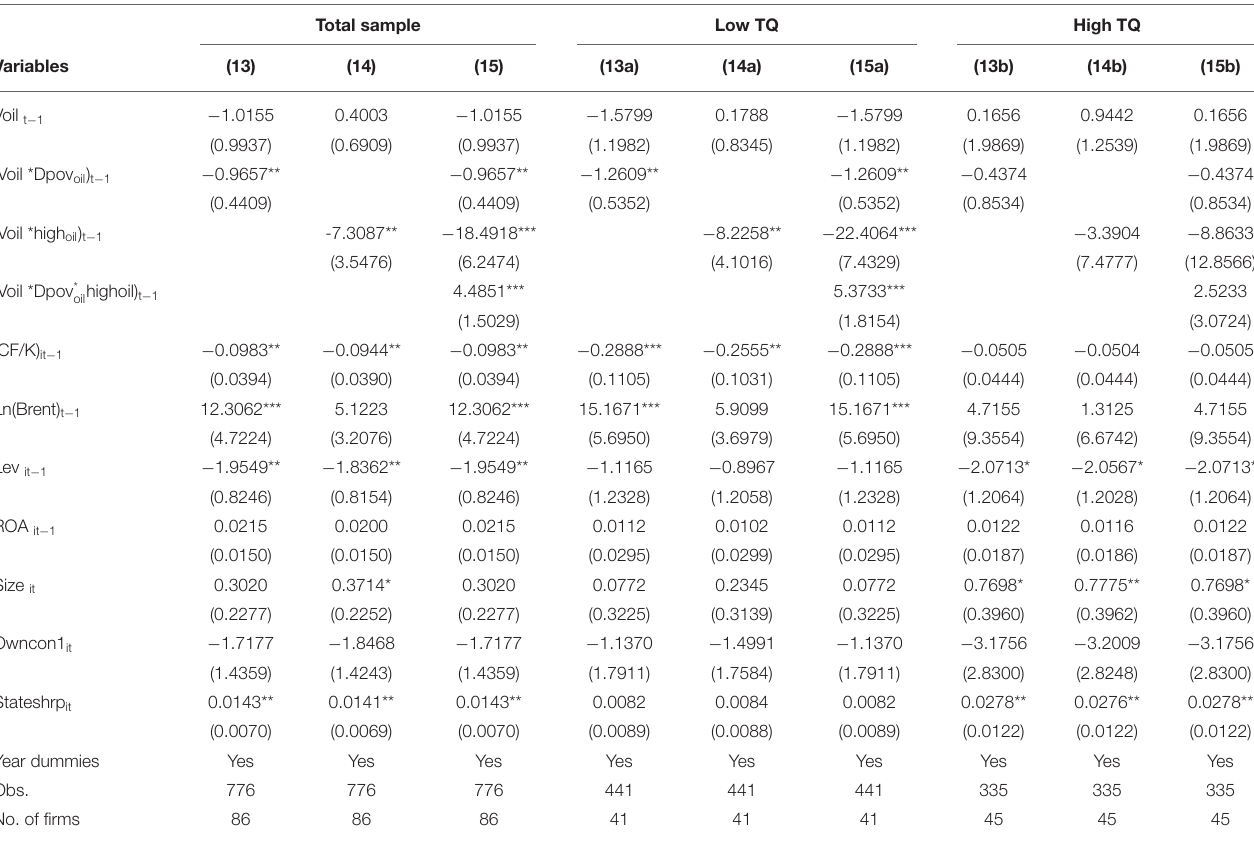
TABLE 6 | The impact of oil price uncertainty on